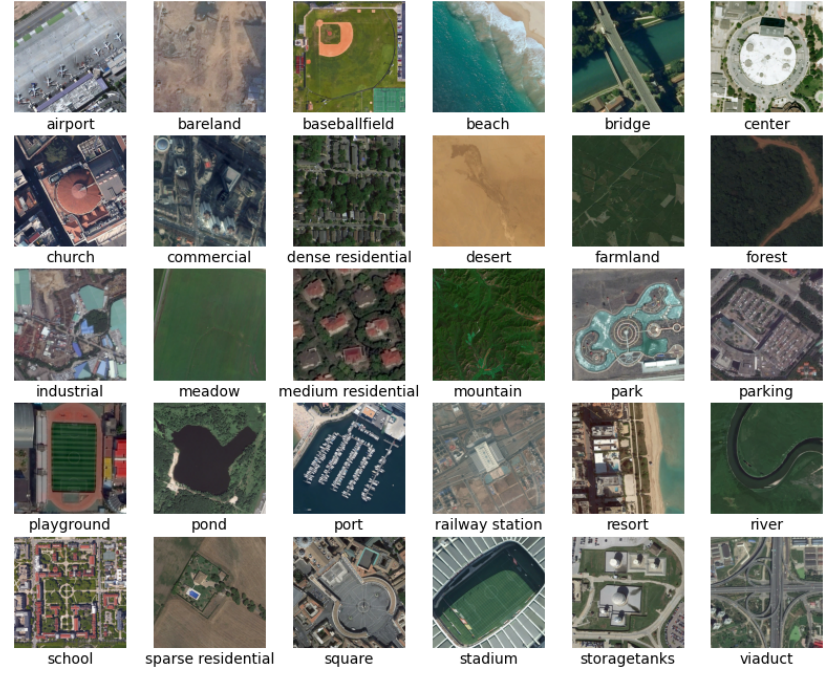
Figure 11. Several images in AID